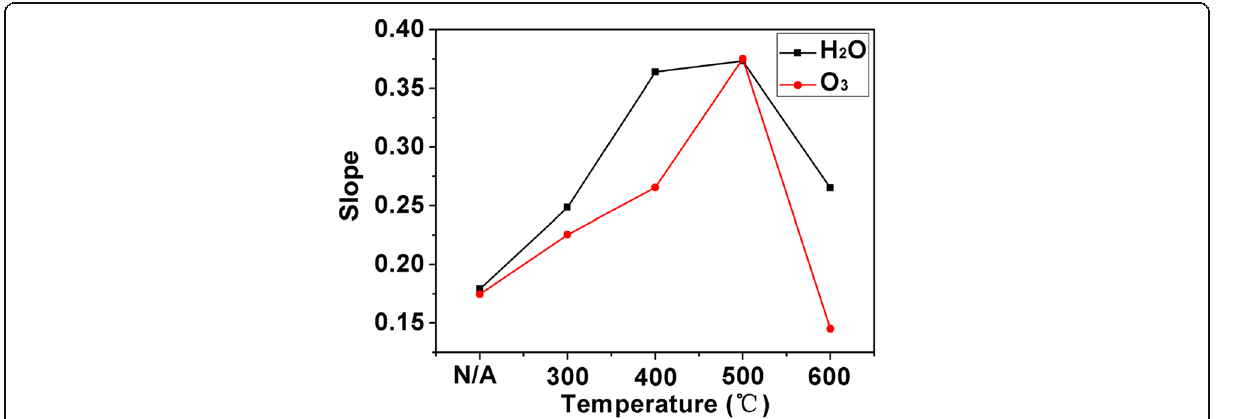
Fig. 5 The maximum ratio of capacitance density and voltage of the capacitors with different annealing